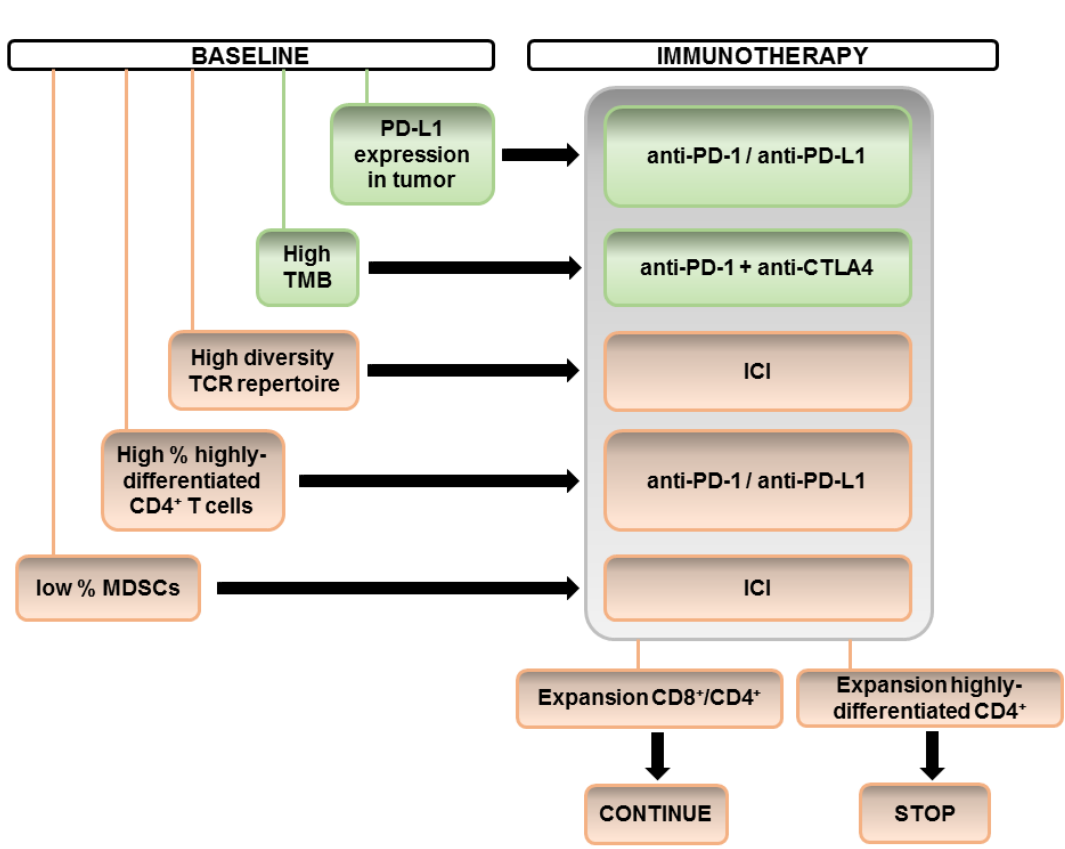
Figure 1. Suggested application of a sequential algorithm to patient selection for immune checkpoint inhibitors (ICI) therapy. Before starting ICI therapies, PD-L1 tumor expression and tumor mutational burden (TMB) determination can be provided as biomarkers under current clinical practice (green).